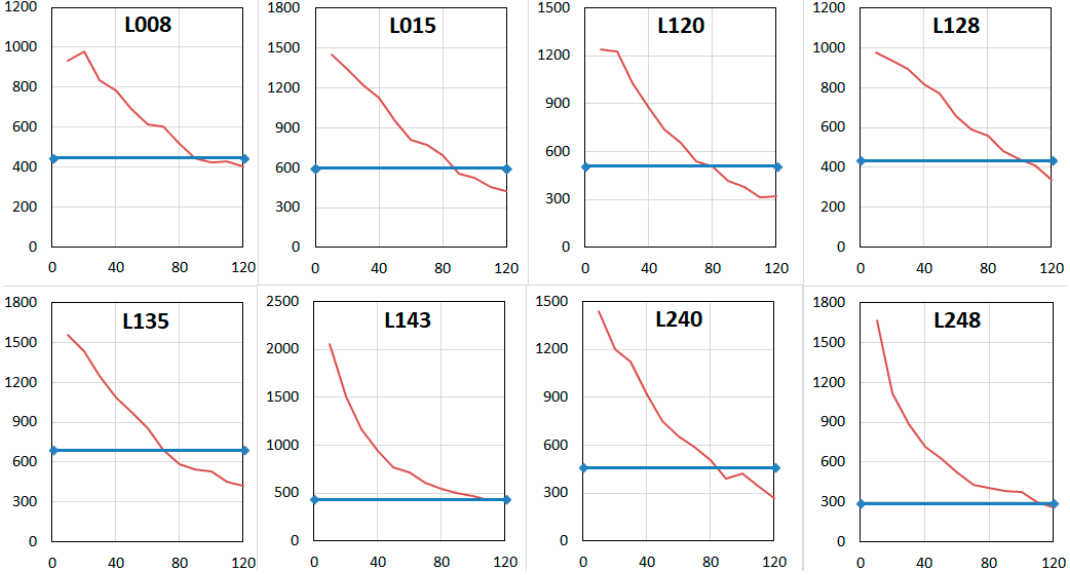
Figure 13. Synthetic images generated using radial uniform sampling with a coarse to fine variation of lateral resolution parameter n u .